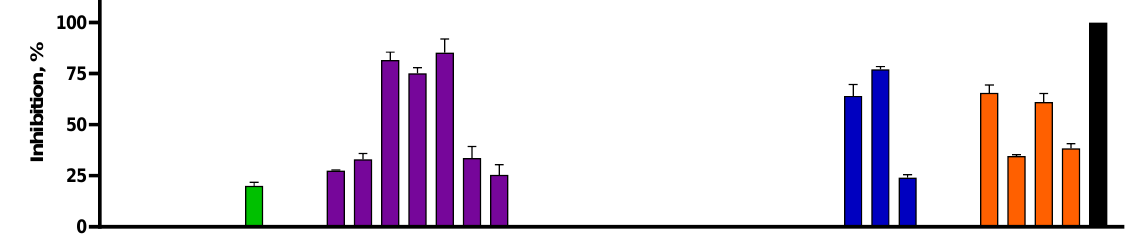
Chemosensors 2023 , 11 , x FOR PEER REVIEW 12 of 16